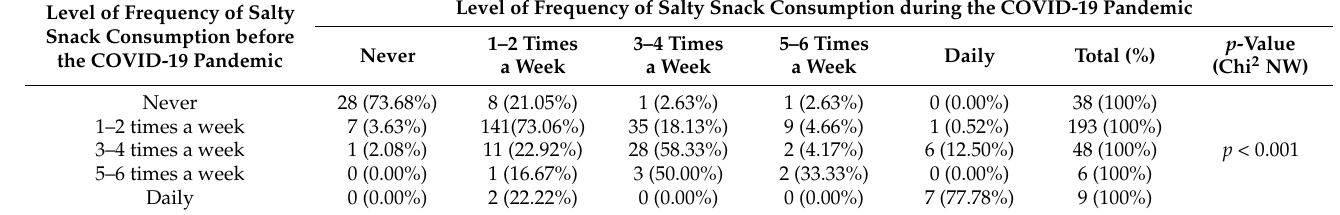
Table 4. Prevalence level of salty snack consumption before and during the COVID-19 pandemic.